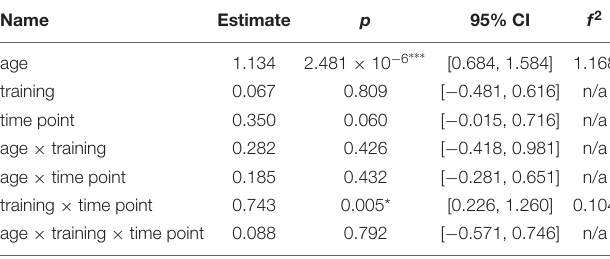
TABLE 2 | Generalized linear mixed-effects model results for the composite WM